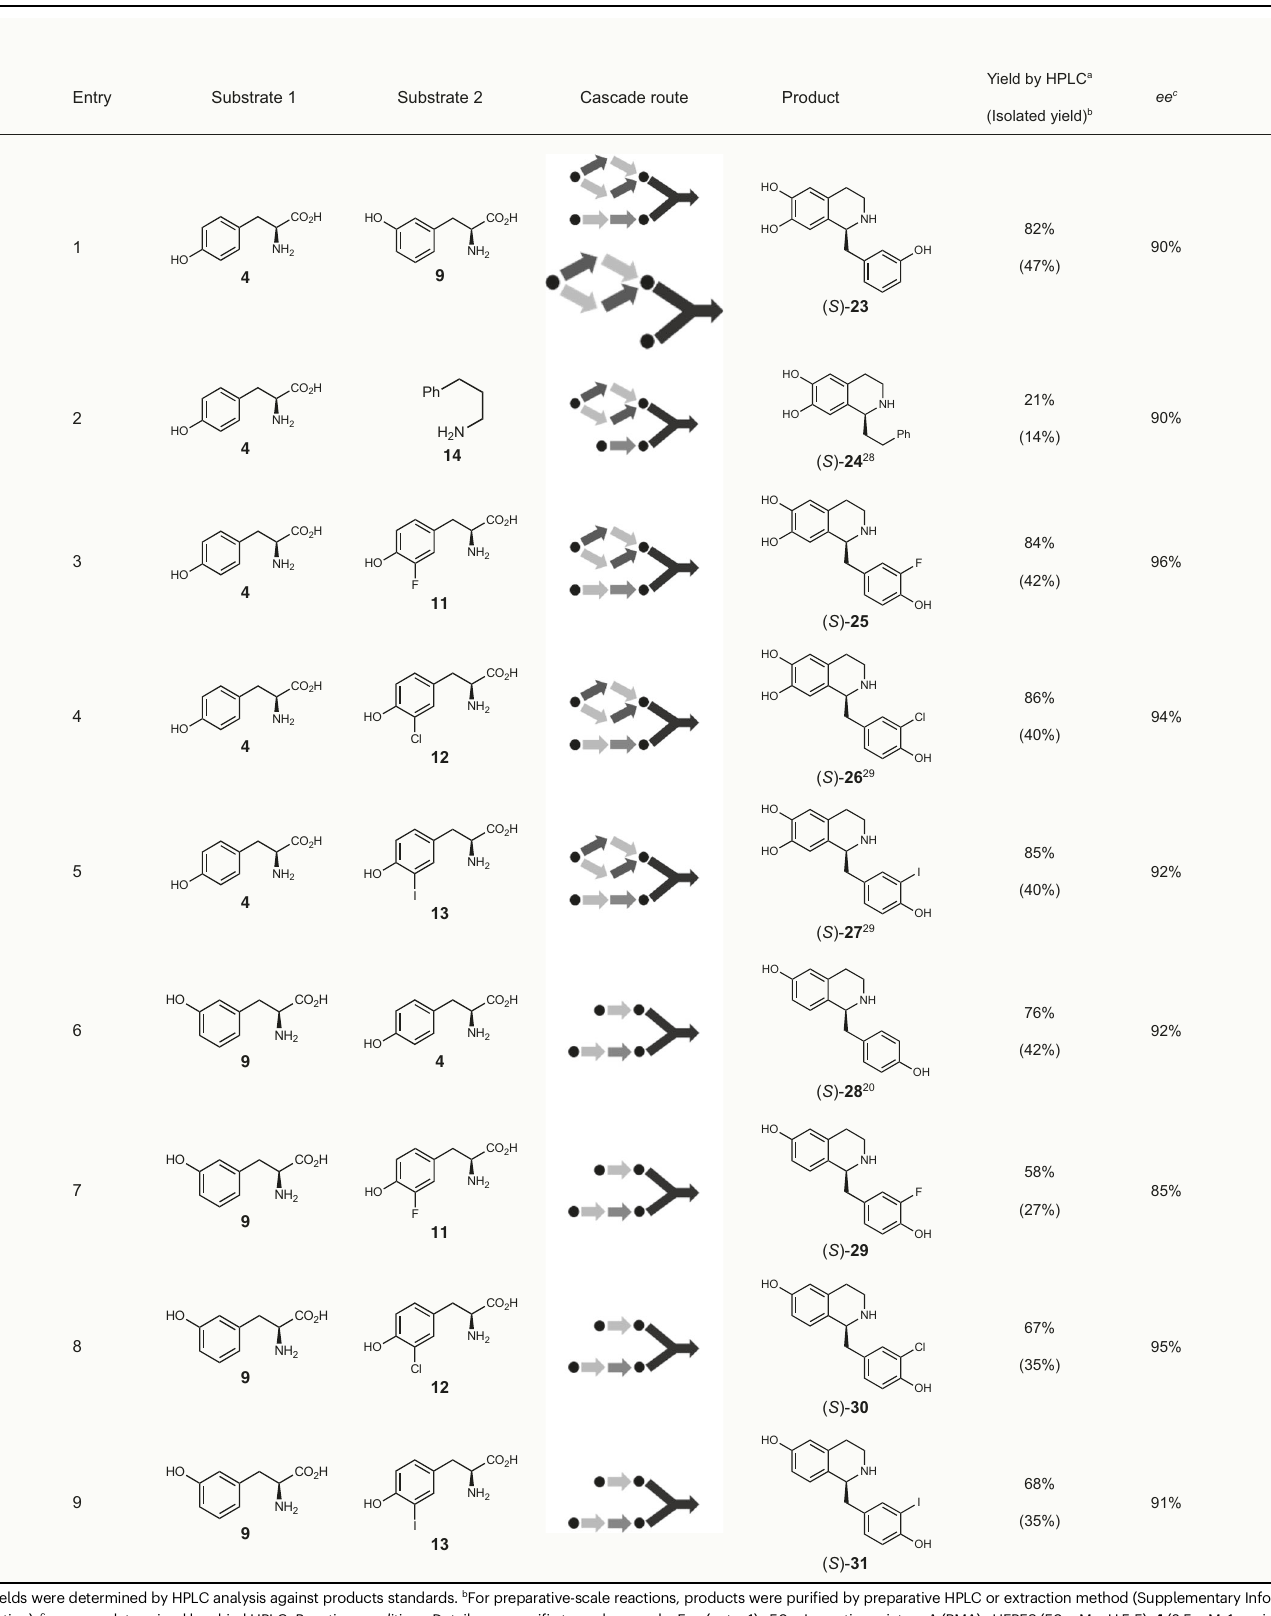
Table 2 | Use of the parallel cascades to produce BIAs 23 –